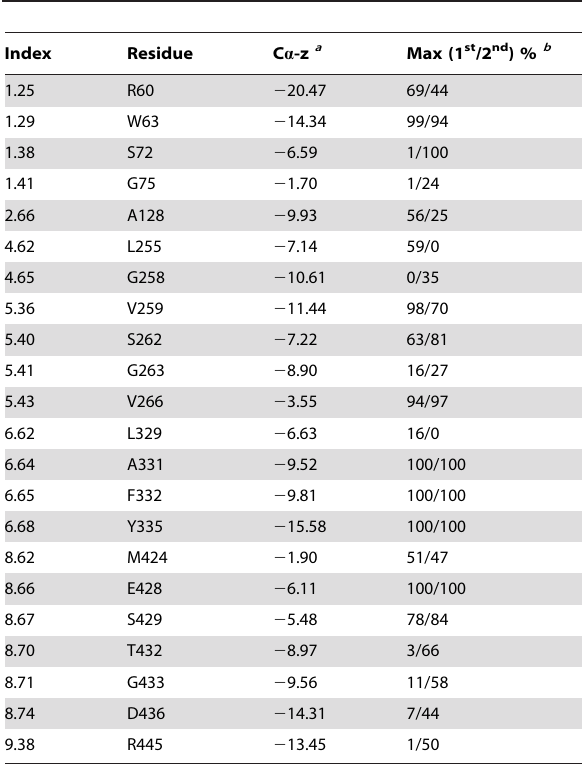
Table 4. The substrate translocation pathway from the S1 site to the intracellular site.